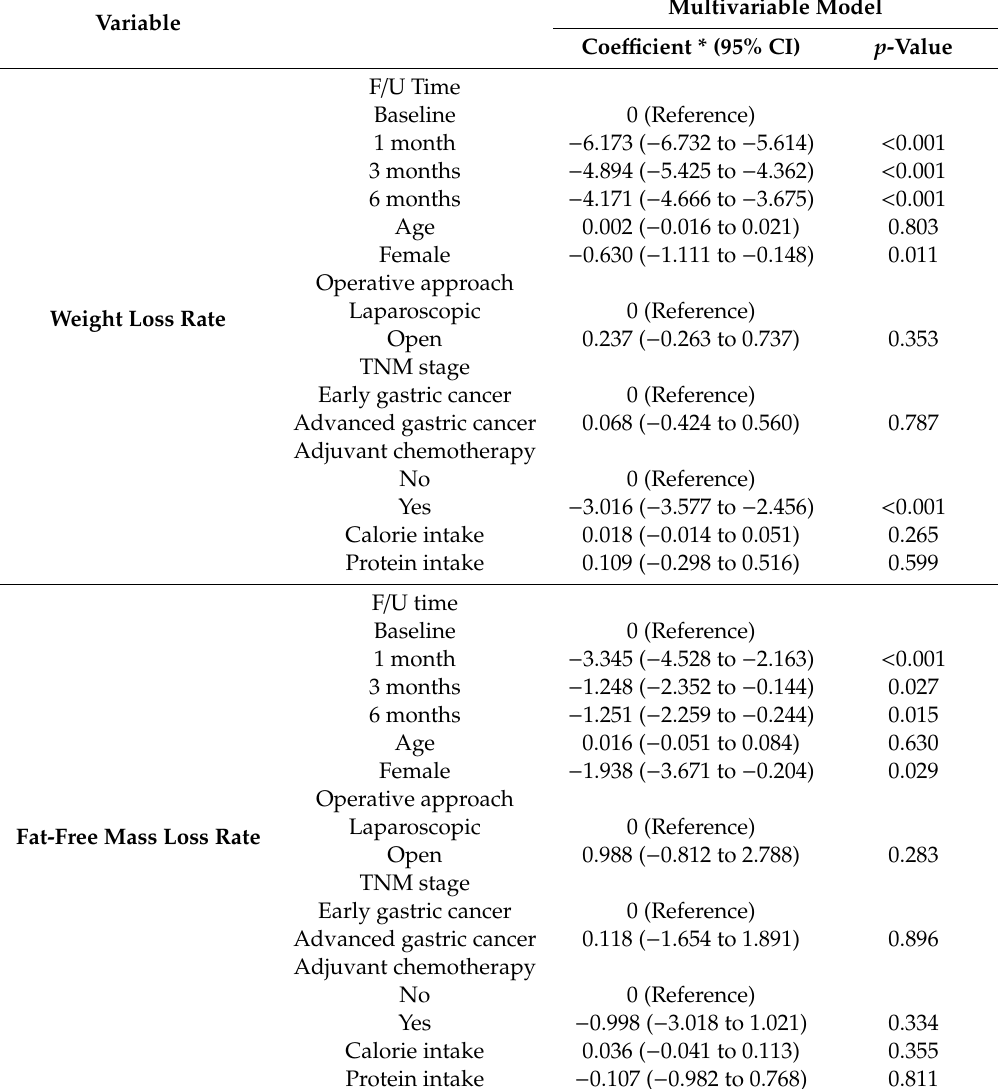
Table 4. Association between the clinical factors, weight, and fat-free mass (FFM) loss rate after